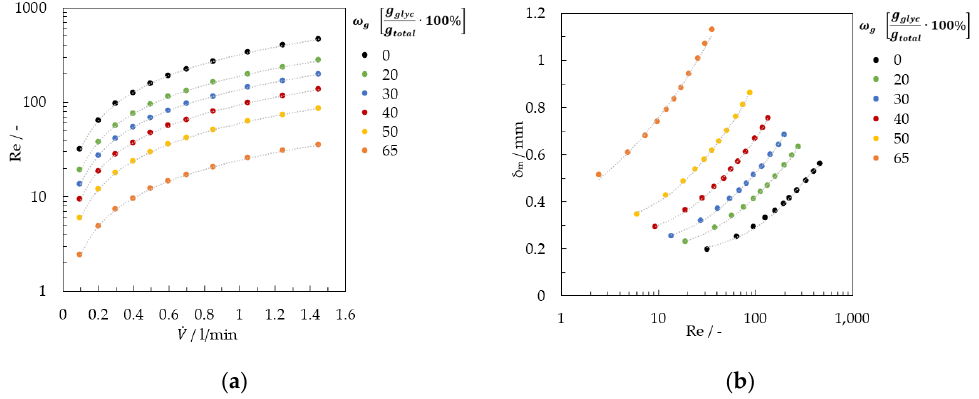
Figure 4. Fluidic characterization of the falling film ( a ) Reynolds number and ( b ) average film thickness. The average film velocity w was calculated using Equation (5) and is shown as a function of the Reynolds number in Figure 5.